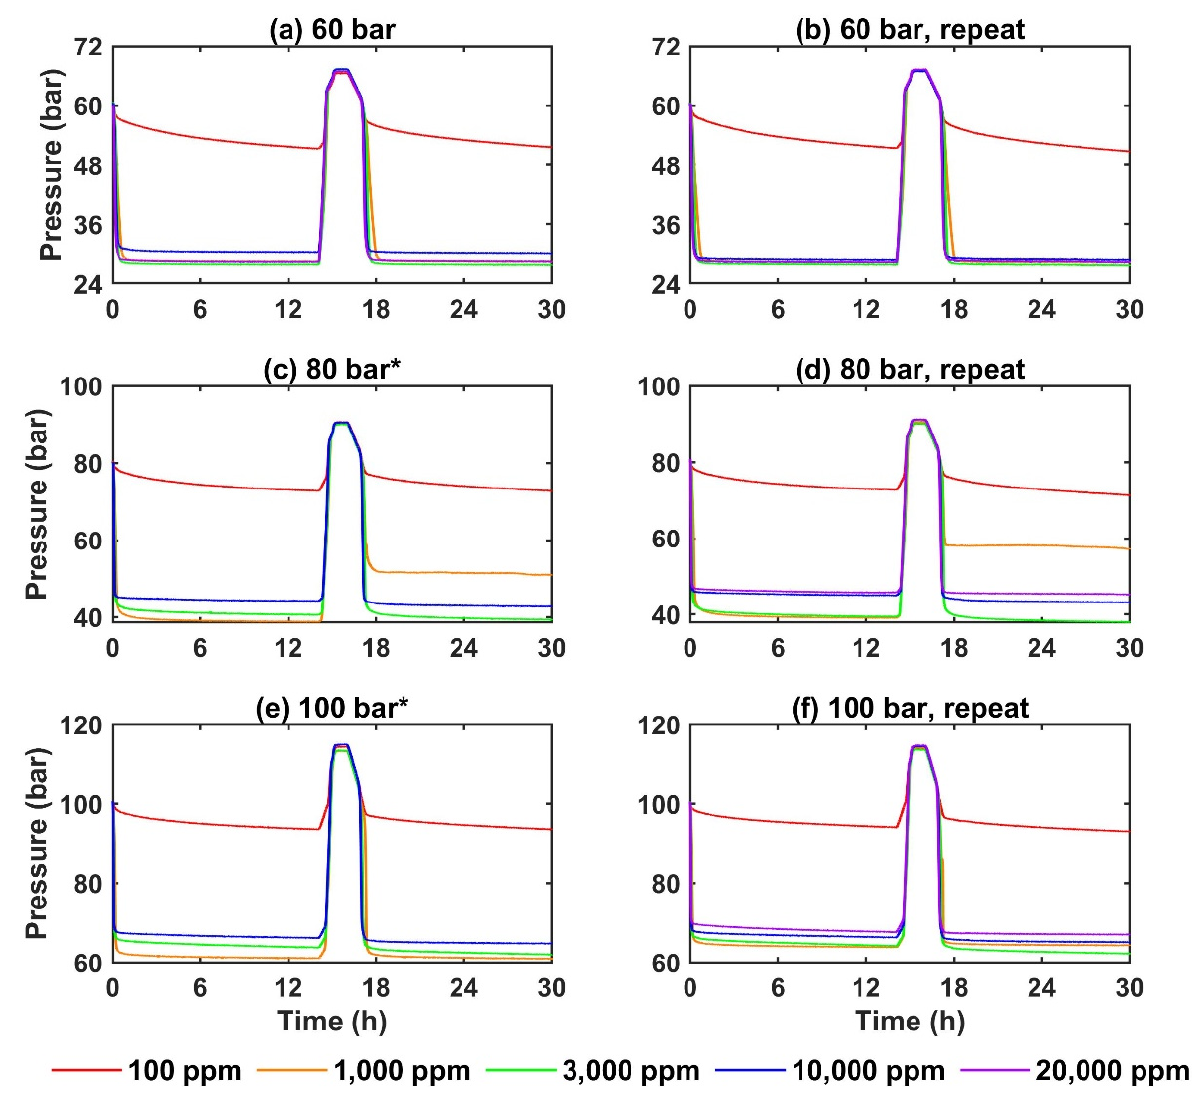
Figure 8. Pressure variation (for fresh and memory run) during the isothermal experiment temperature (T = 1 ° C ) scheme (in the presence of L-methionine) at five different concentrations (100 ppm to 20,000 ppm) for three different pressures (60, 80 and 100 bar). ( a , b ) show pressure profiles during isothermal under 60 bar initial pressure; ( c , d ) shows pressure profiles during an isothermal experiment under 80 bar initial pressure. ( e , f ) shows pressure profiles during an isothermal experiment under 100 bar initial pressure.